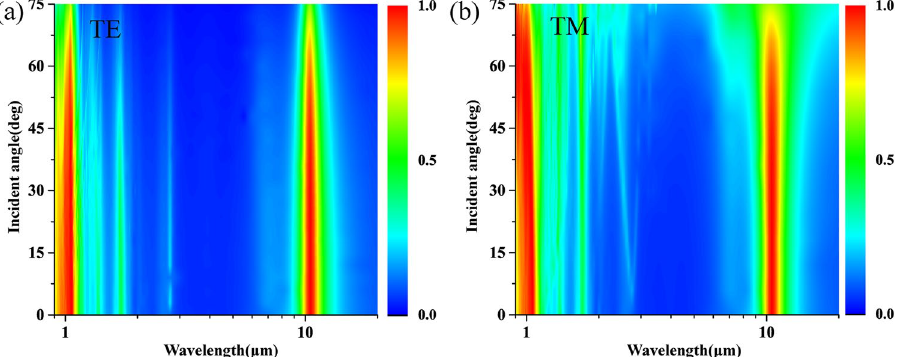
Figure 2. Absorption spectrum of the designed dual-band perfect absorber as a function of wavelength and the incident angle under different polarizations. ( a ) TE mode and ( b ) TM mode.